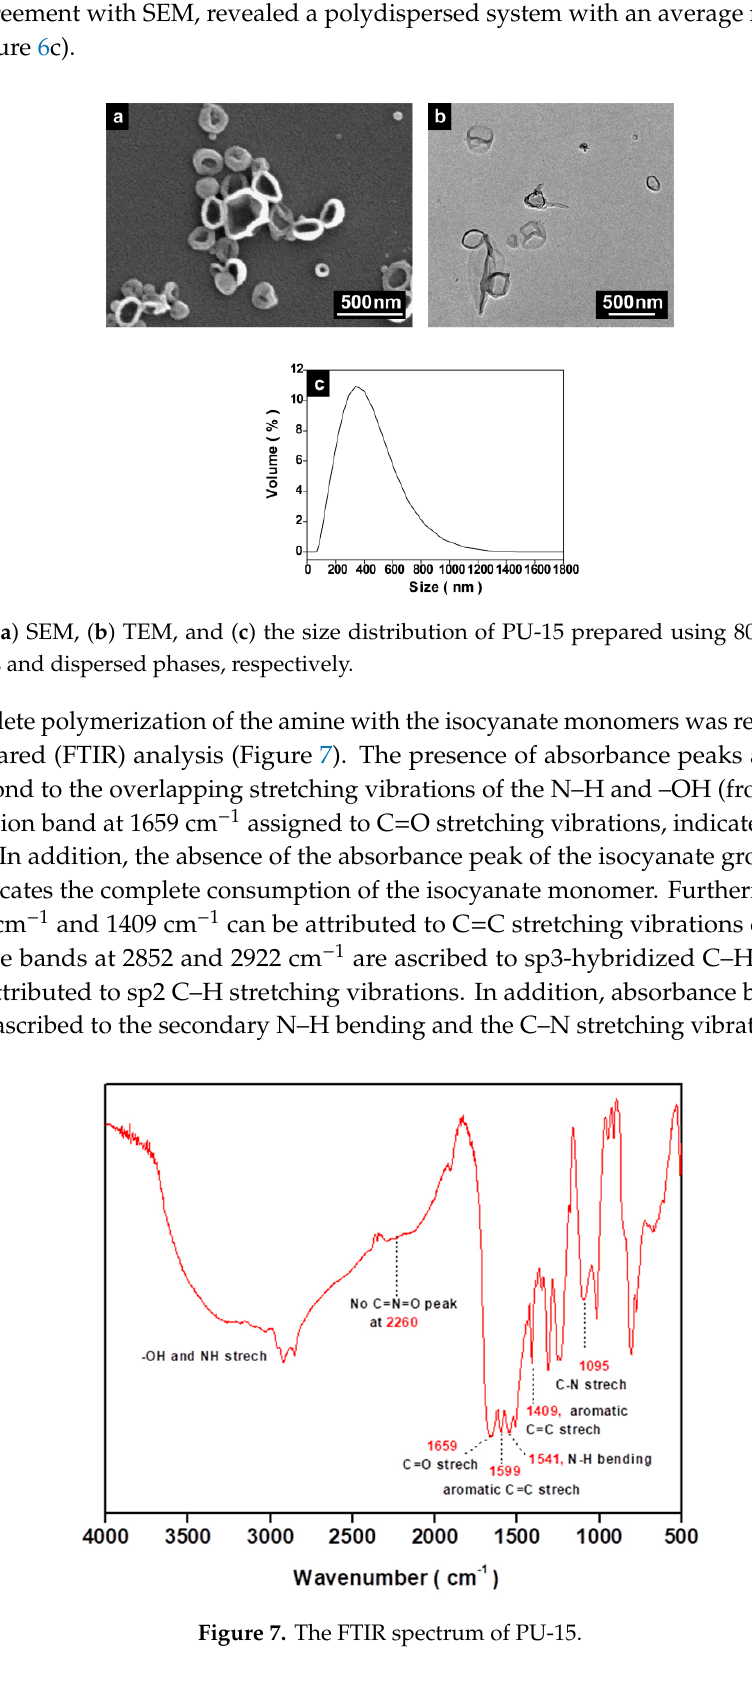
Figure 7. The FTIR spectrum of PU-15.